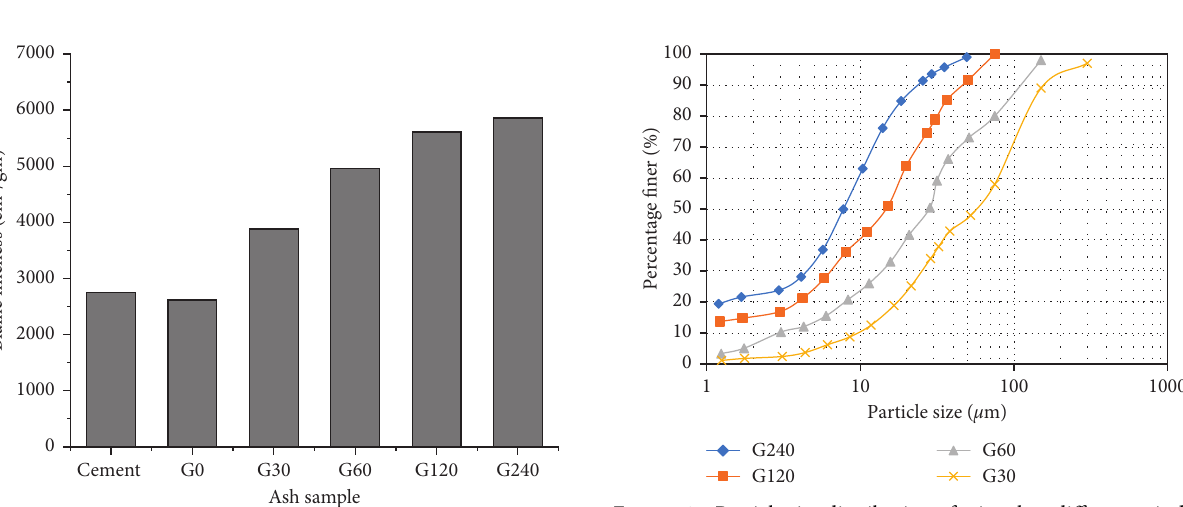
Figure 13: SEM of corn stalk ash: (a) Mesh sheets particle, (b) filling of pores by smaller particles at higher grinding duration, (c) pores in cellular particles, and (d) pores in prismatic particles.